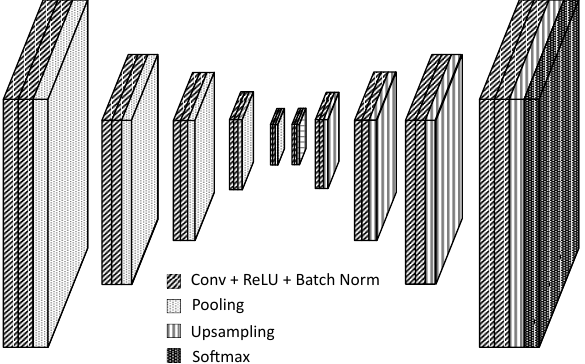
Figure 4. SegNet FCN. Encoder-decoder architecture with convolutional, pooling, and upsampling layers with their corresponding activation functions and batch normalization